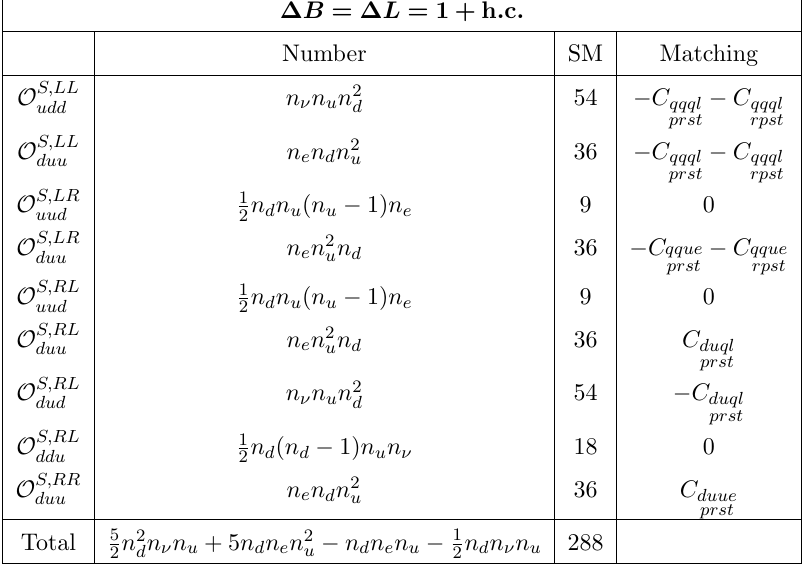
Table 20 . Dimension-six ∆ B = ∆ L = 1 operators in LEFT. There are also Hermitian conjugate ∆ B = ∆ L = 1 operators, as indicated in the table heading. The second column is the number of − operators for an arbitrary number of neutrino flavors n ν , charged lepton flavors n e , u -type quark flavors n u , and d -type quark flavors n d , and the third column is the number in the SM LEFT with n ν = 3, n e = 3, n u = 2, and n d = 3. The last column is the tree-level matching coefficient in SMEFT.